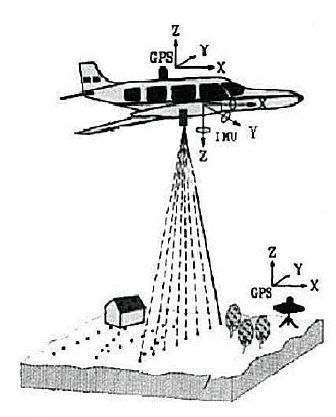
Figure 2. Schematic diagram of working principle of airborne